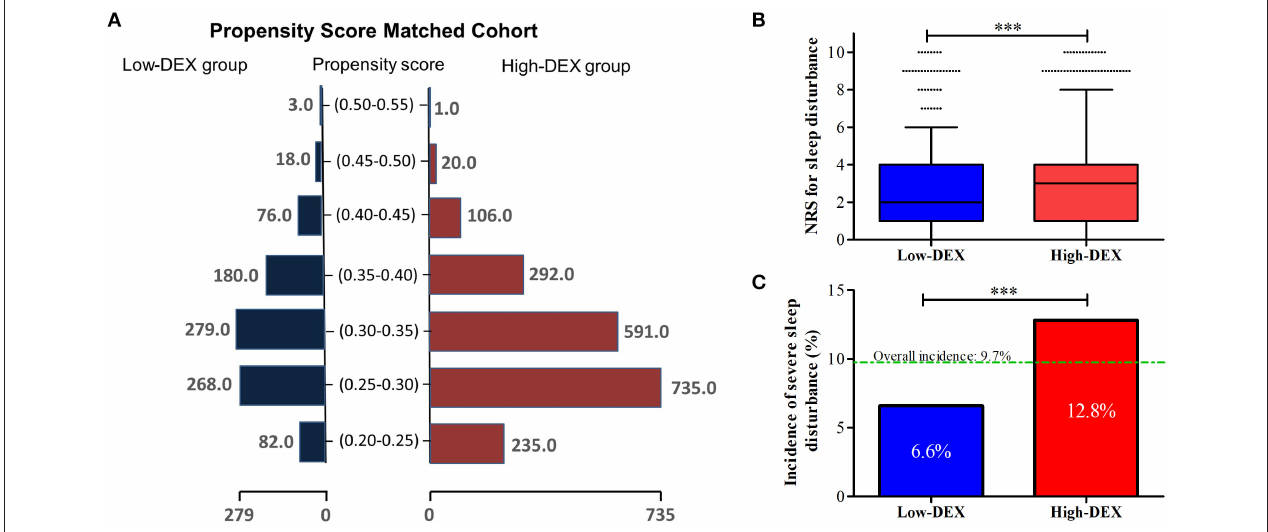
FIGURE 4 | Propensity score-matched analysis for comparisons between Low-DEX and High-DEX group patients. (A) Distributions of elderly surgery patients in the Low-DEX and High-DEX groups in propensity score-matching. (B,C) NRS for sleep disturbance and the incidence of SSD during the first night after the surgery in Low-DEX ( n = 906) and High-DEX group ( n = 906) patients after PSM analysis. *** P < 0.001; (B) box plot, interquartile range; solid line, median; whiskers, third quartile + 1.5* interquartile range; dots, abnormal value. (C) box, percentage.